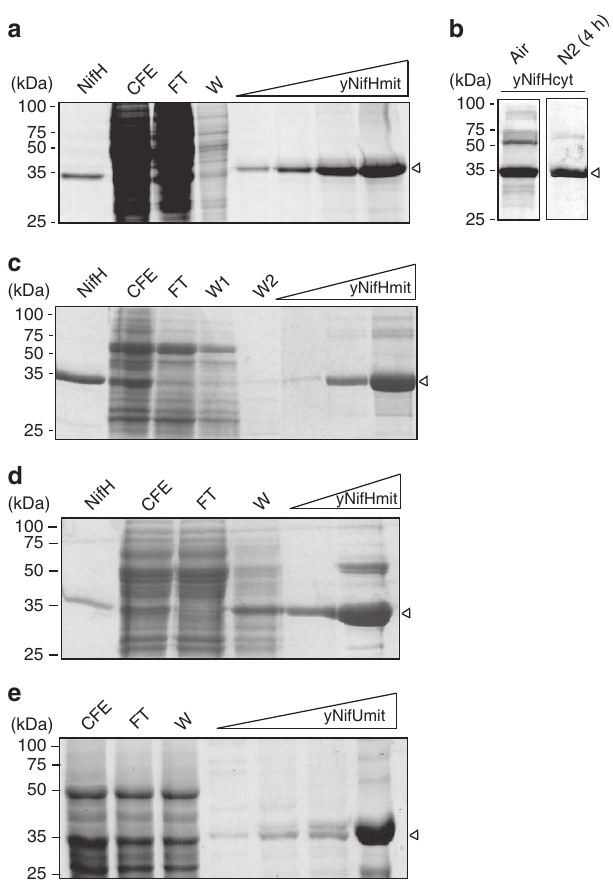
Figure 2 | Purification of yNifH and yNifU proteins. Aerated cultures